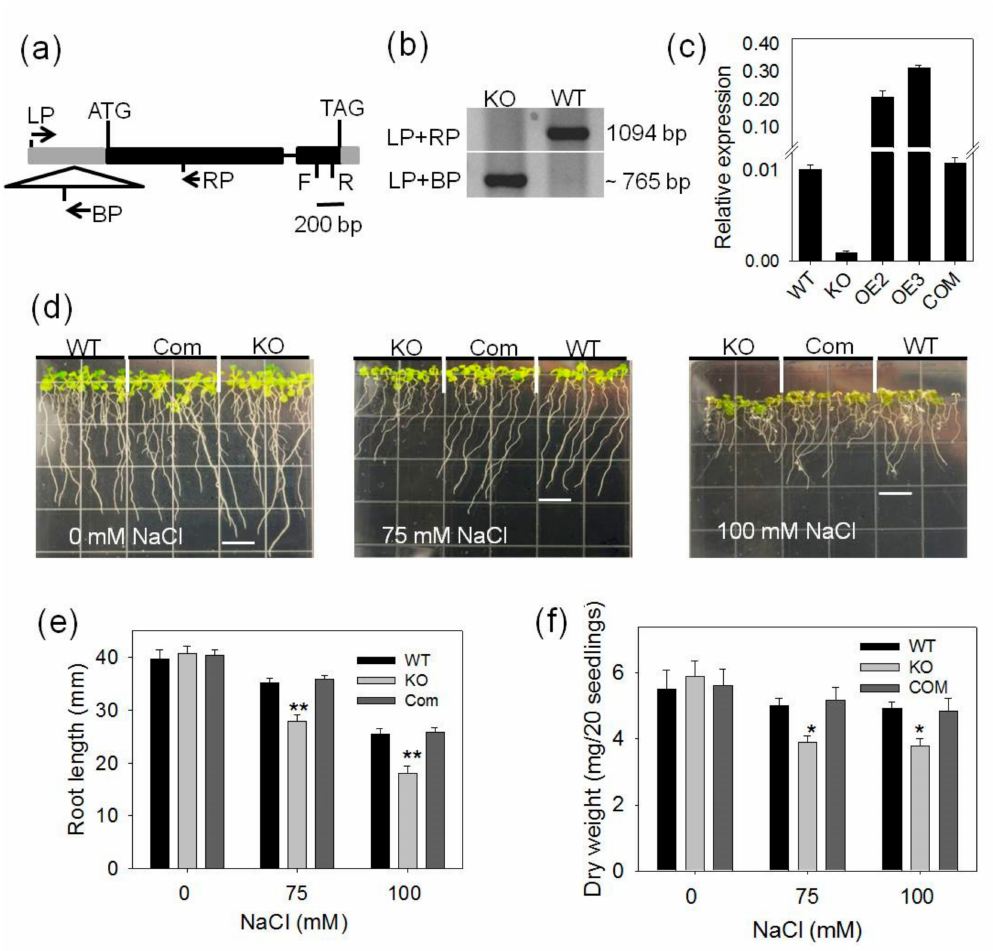
Figure 1. pPLAIII γ -KO, its complementation (COM) and response to di ff erent NaCl concentrations; ( a ) T-DNA insertion site in pPLAIII γ . Solid boxes indicate exons, thin lines indicate introns, gray boxes represent the untranslated regions (UTR) at both the 5 (cid:48) and 3 (cid:48) positions. Arrows (LP, BP and RP) show positions of primers used for PCR. F and R present positions of JLP053 and JLP054 primers, respectively, for pPLAIII γ relative expression in qPCR; ( b ) PCR-confirmation of T-DNA insertion in pPLAIII γ using genomic DNA; ( c ) relative gene expression of pPLAIII γ in WT, KO, OE and COM lines by qPCR. UBQ10 was used as internal control. Data are means ± SE ( n = 3); ( d ) representative images of seedlings grown on half-strength MS media supplemented with 0, 75 and 100-mM NaCl. Measurement of primary root length ( e ) and dry weight ( f ) of WT, KO and COM lines. Seedlings were grown for 7 days under di ff erent treatments after transferring and then measured. Values are mean ± SE (n = 45–60 for root length or 3 biologic repeats for dry weight. One and two asterisks indicate significant di ff erences from WT by Student’s t-test at p = 0.05 and p = 0.01,